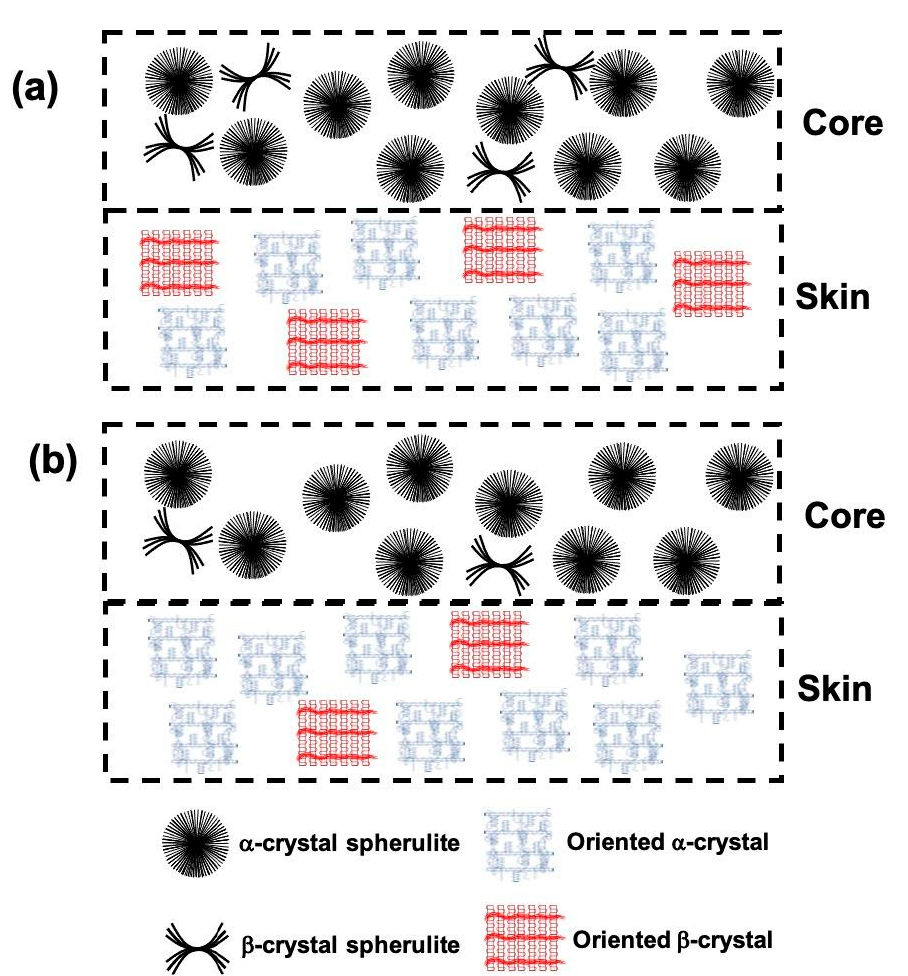
Figure 10. Schematic illustration of crystalline morphology in the skin and core sections of specimens obtained for ( a ) low molecular weight iPP and ( b ) high molecular weight iPP. Table 4. Summary of results from DSC. Amplitude affects the crystallinity, and the chain scission is more evident in the onset of the melting temperature (T m ). 1st Heating Cycle